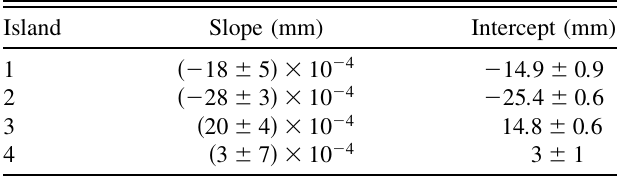
TABLE I. Linear fit results of the islands’ position (cid:5) i as a function of total beam intensity ( N total in units of 10 10 protons ) obtained from the data plotted in Fig.